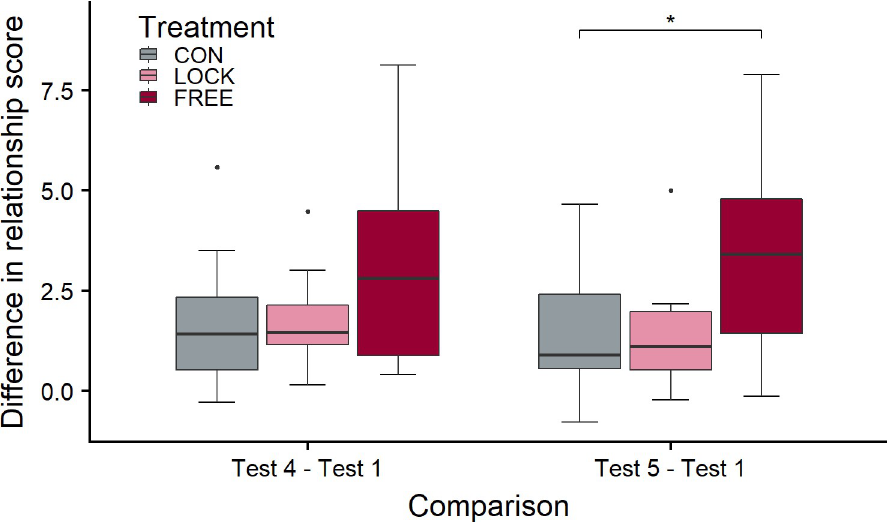
Fig 4. Change in the relationship score from test 1 to test 4 and from test 1 to test 5 in the three treatment groups. The FREE group experienced gentle interactions with a person while free in the barn, the LOCK group while restrained in the feeding rack; the CON group did not experience gentle interactions. Test 4 took place after the treatment period of 6 weeks with a total of 30 treatment days, test 5 2 weeks later. No treatment took place between tests 4 and 5. LMM: treatment p < 0.1 for test 5, ns for test 4; � : p < 0.05 for pairwise comparison; n CON = 11, n LOCK = 11, n FREE =